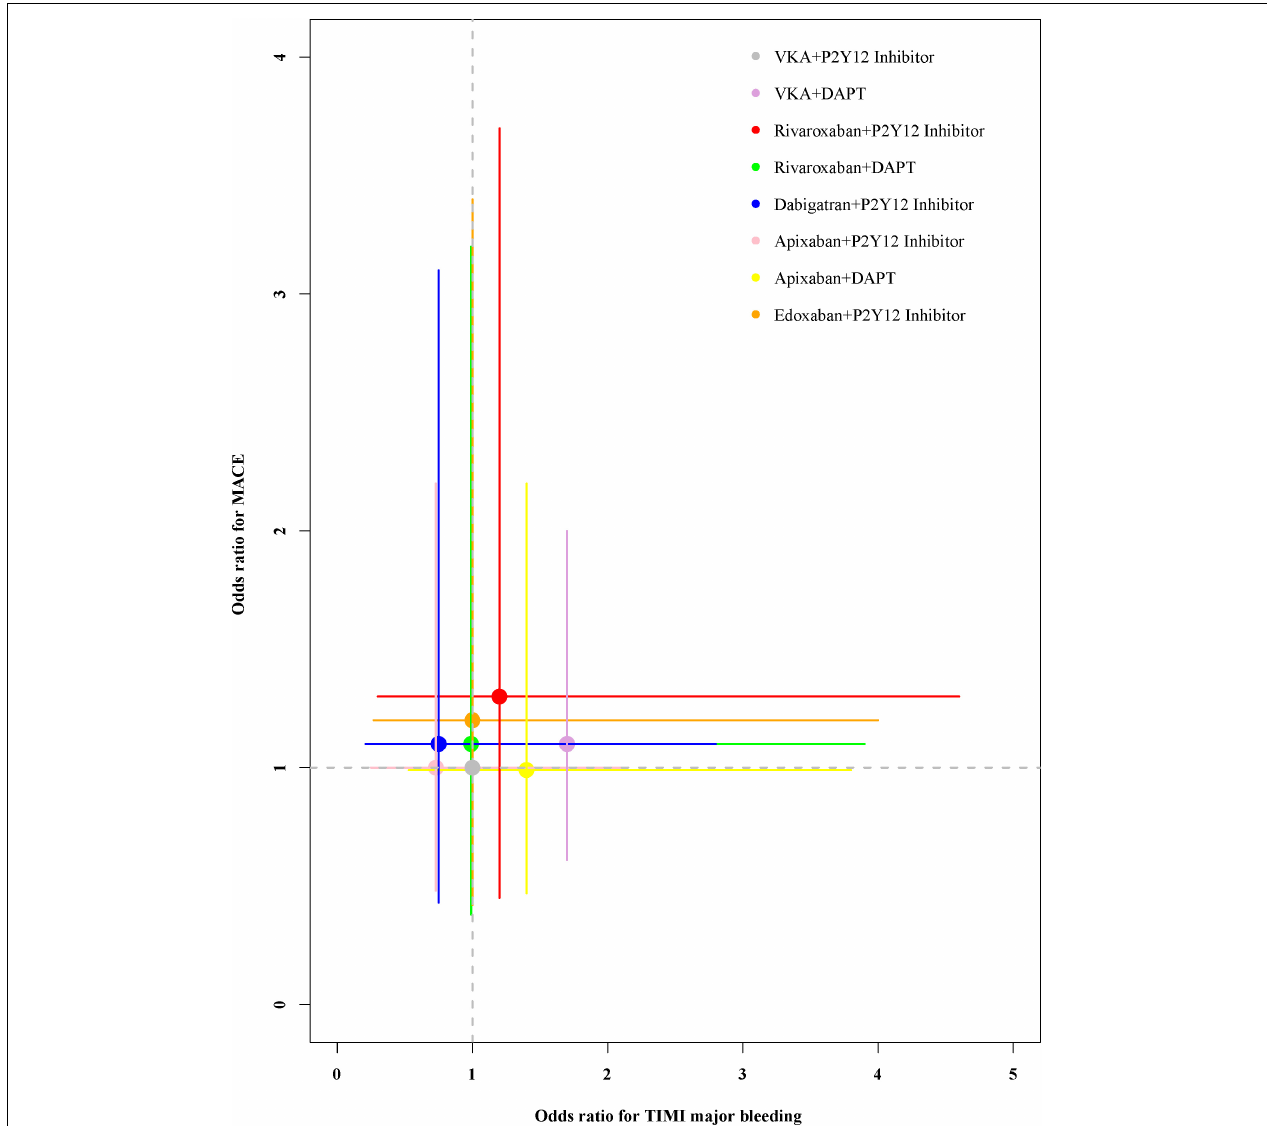
FIGURE 5 | Odds ratios for TIMI major bleeding and trial-defined